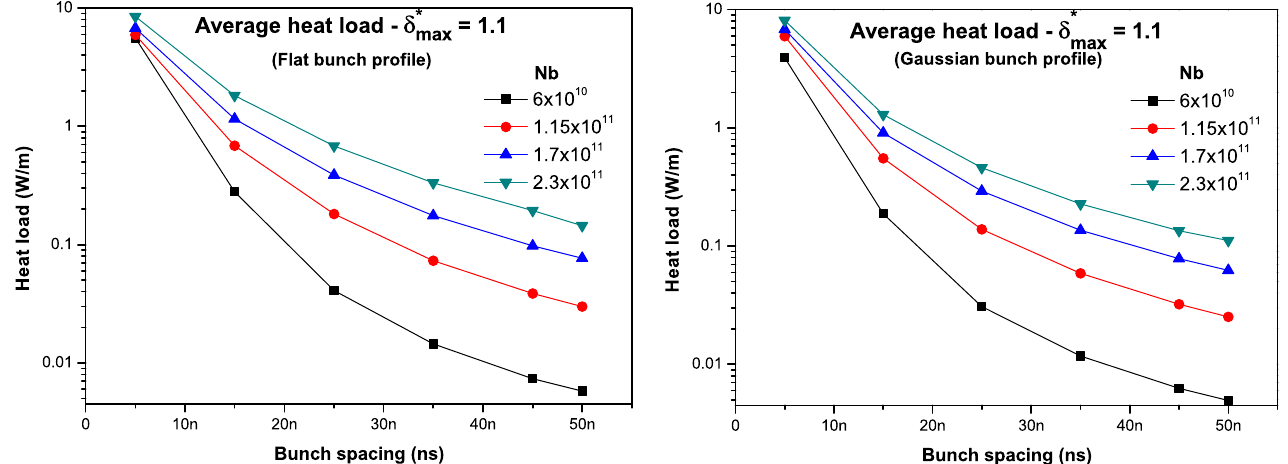
FIG. 14. Average heat load in function of the bunch spacing and a (cid:1) (cid:3) max ¼ 1 : 1 for (a) flat bunch profile and (b) nominal Gaussian bunch